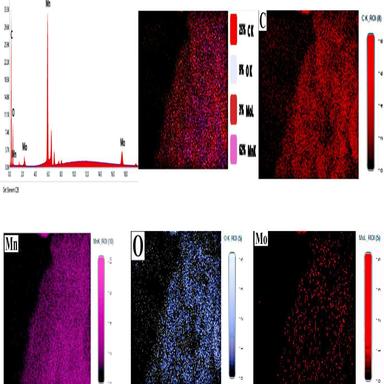
EDX-mapping of mesoporous (Mo–MnO2/MWCNT) composite.